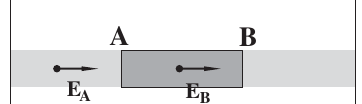
FIG. 2. The electric field at a point outside the resistor is equal to the electric field at a point inside the resistor.